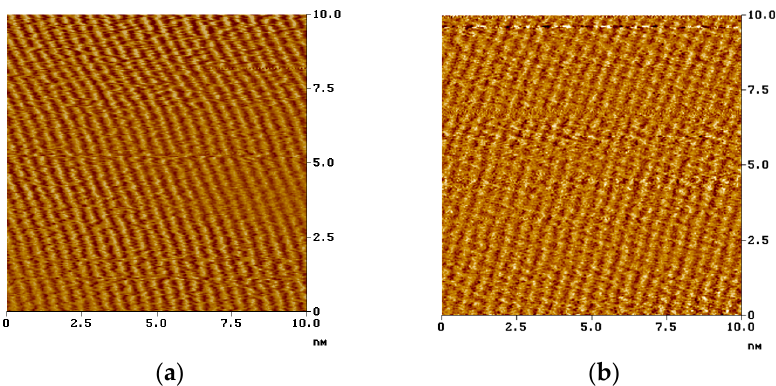
Figure 6. Nanostructure of the stearoyl phosphonic acid SAM layer formed on copper and carbon steel surface, visualized by atomic force microscopy (NanoSocpe III, contact mode, ex situ technique, on air); ( a ): on carbon steel; ( b ): on copper [118]. Corrosion Engineering Science and Technology, 2004 (copyright: Institute of Materials, Minerals and Mining, reprinted by permission of Taylor & Francis Ltd.).